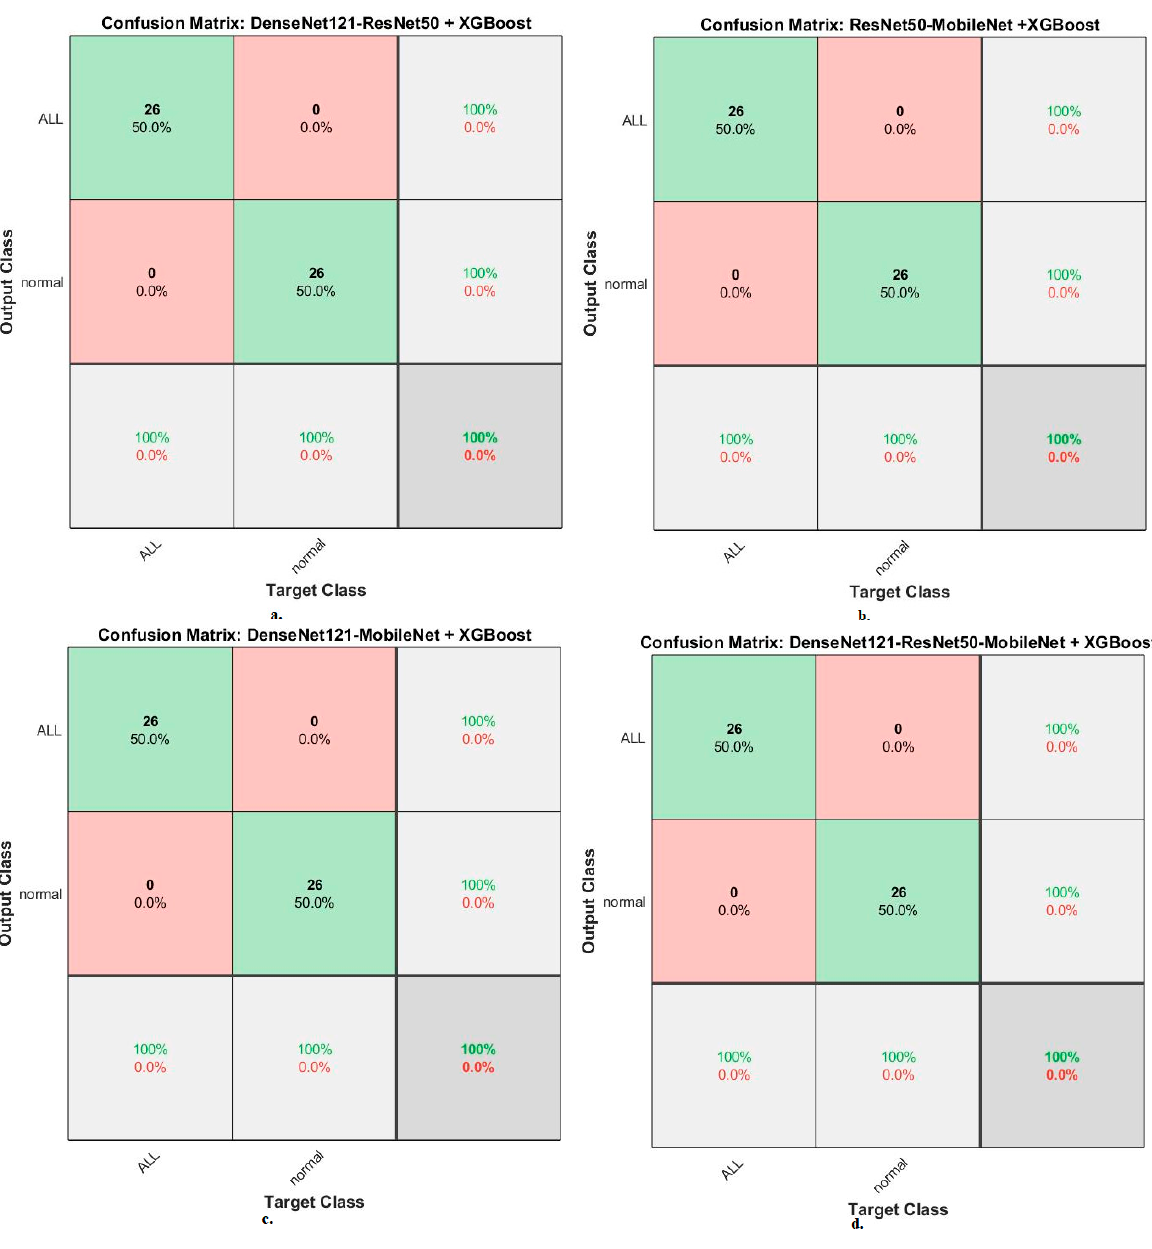
Figure 18. Results of the XGBoost classifier based on fusion features of the CNN models of the ALL-IDB2 dataset for the diagnosis of acute leukemia, confusion matrix of ( a ) DenseNet121-ResNet50, ( b ) ResNet50-MobileNet, ( c ) DenseNet121-MobileNet, and ( d ) DenseNet121-ResNet50-MobileNet.